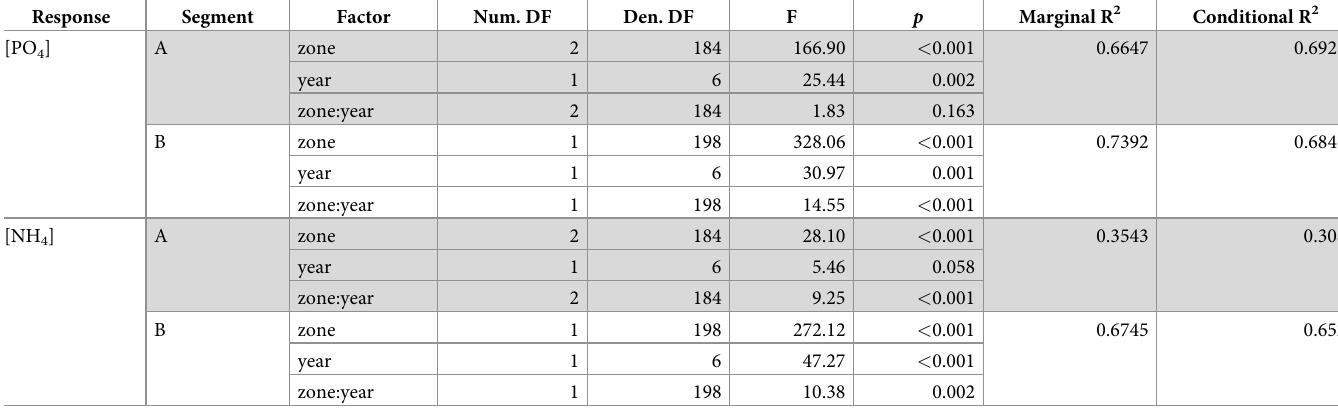
Table 1. Linear mixed effects model